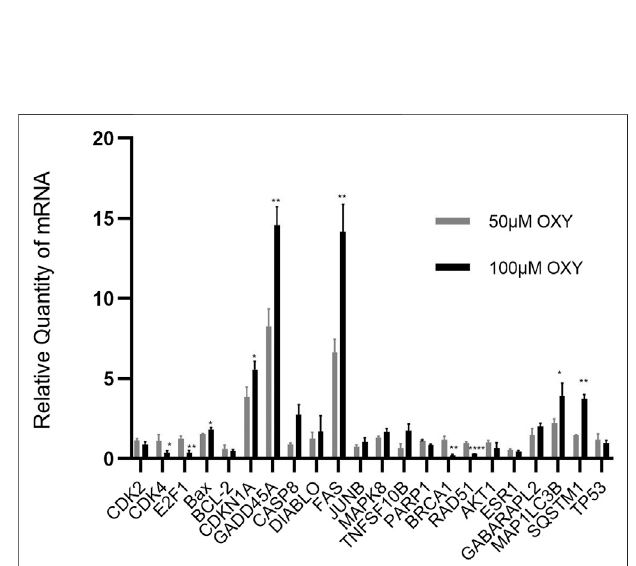
FIGURE 5 | Relative quantity of mRNA expression from MCF-7 cells treated withOXY.Validationofselectedgenes differentiallyexpressedinMCF-7 cells treated for 24 h with 50 or 100 µM of OXY vs. control data set. Statistical analysis was carried out using unpaired t test (* p < 0.5, ** p < 0.05 and **** p <